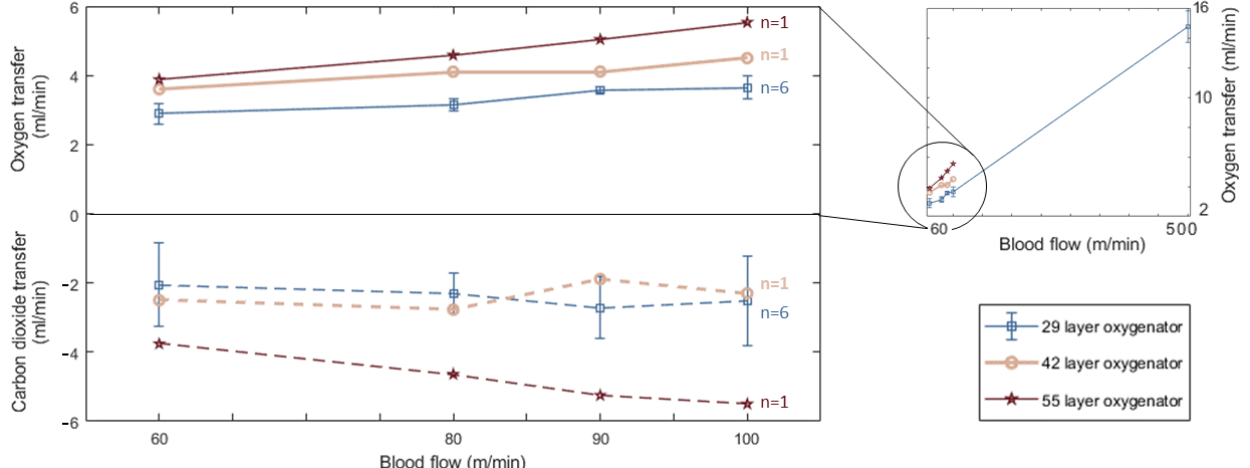
Figure 5. Gas transfer efficacy over blood flow for three different fiber mat layer numbers. The zoomed-out graph on the right further shows two measured values for 500 mL/min blood flow to show that a linear extrapolation of the values measured in the lower flow regimes is approximately valid. Blue squares: 29 fiber mat layers, beige circles: 42 fiber mat layers, red stars: 55 fiber mat layers. Solid lines: Oxygen transfer performance, broken line: carbon dioxide transfer performance.